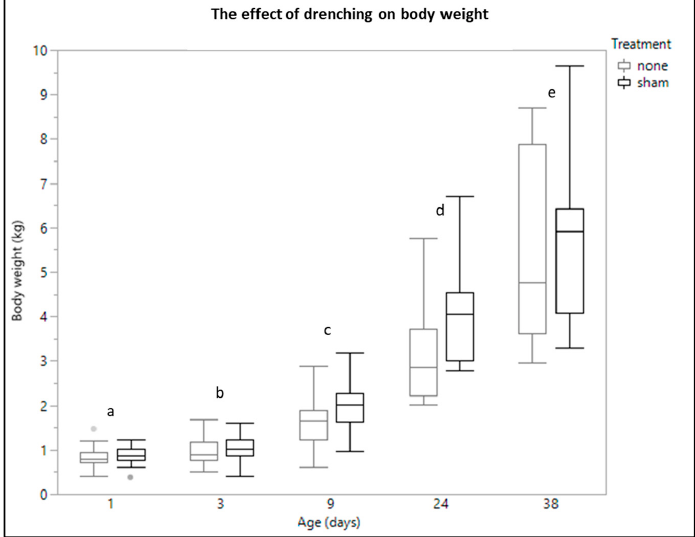
Figure 1. Boxplot of body weight ( n = 76) from low birth weight piglets that received no treatment ( n = 39) or were sham drenched ( n = 37) at different time points (day 1 ( n = 76), day 3 ( n = 50), day 9 ( n = 40), day 24 ( n = 35) and day 38 ( n = 28)). Significant age differences (linear mixed models, Tukey post-hoc analysis, p ≤ 0.05) are indicated by a different letter.